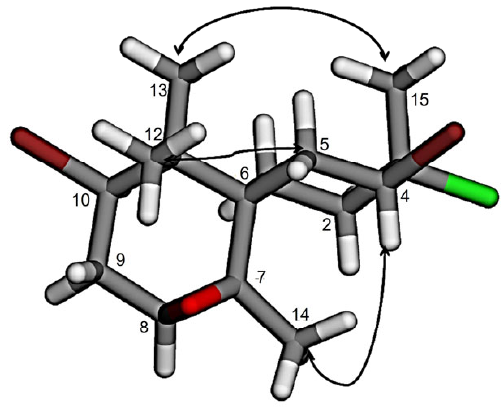
Figure 3. Key NOESY correlations for compound 1 .